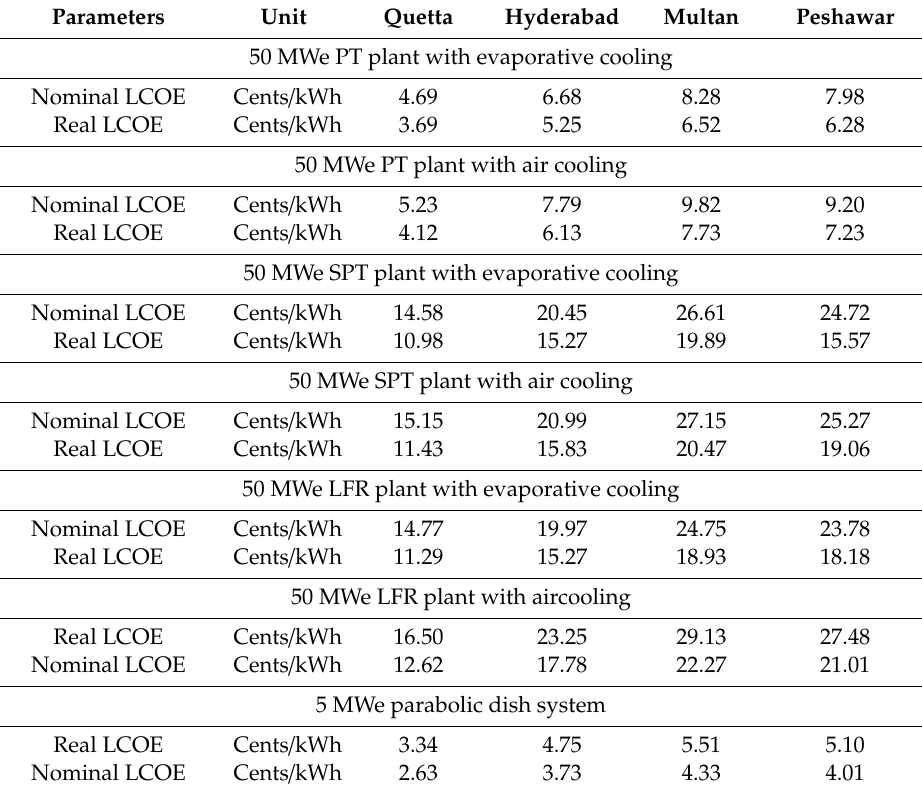
Table 16. Net capital cost and levelized cost of energy (LCOE) of the CSP plants in Pakistan. Parameters Unit Quetta Hyderabad Multan